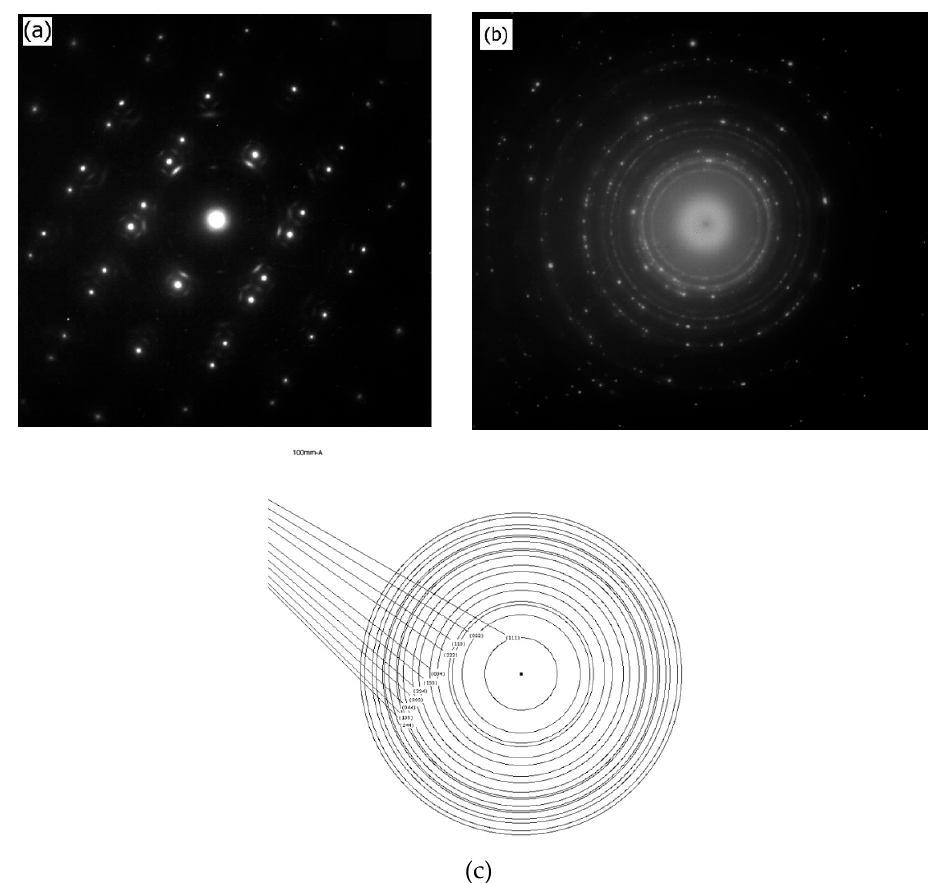
Figure 6. Selected area diffraction pattern (SADP) taken inside the grain in Figure 4: ( a ) single diffraction spots for copper along the [111] axis, ( b ) Debye–Scherrer rings for the pure Al 2 O 3 particles and ( c ) inset showing the simulated Debye–Scherrer rings for γ -Al 2 O 3 .